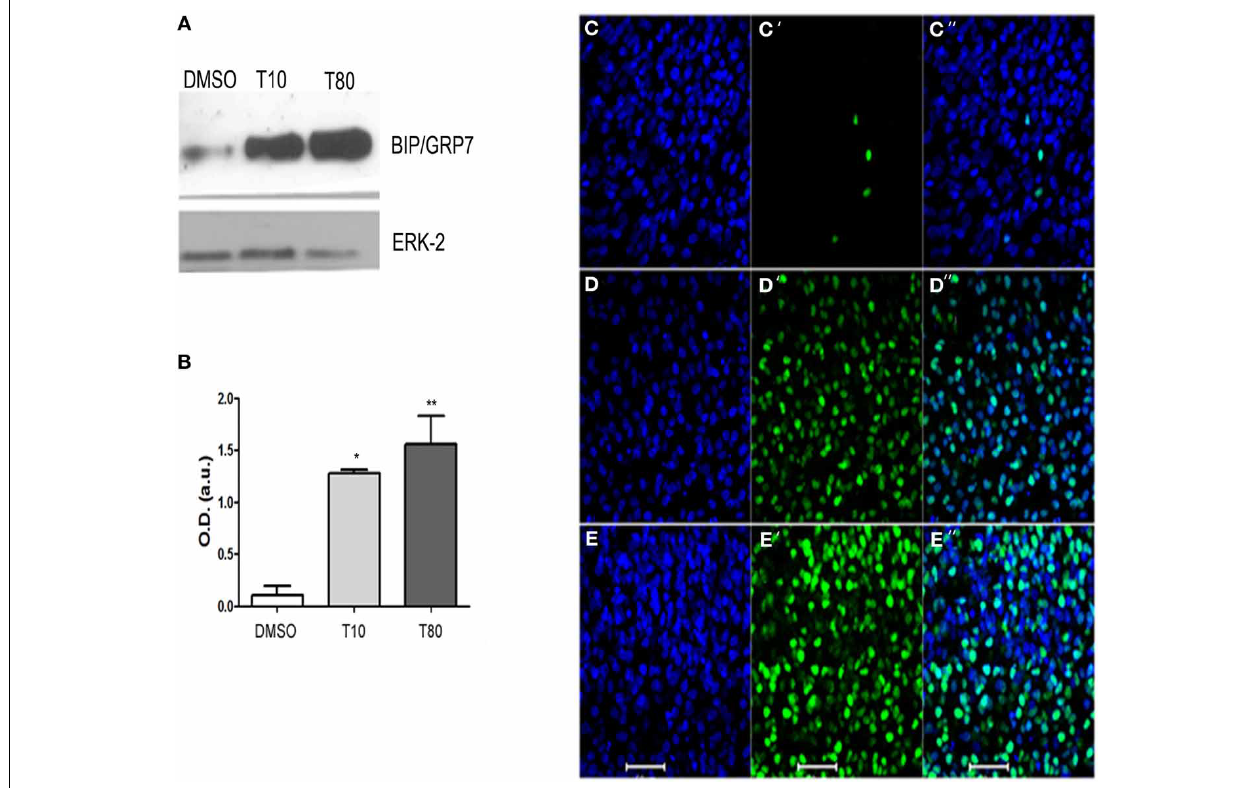
∗∗ p < 0 . 05. ANOVA was performed followed by Bonferroni’s post-test. P < 0 . 01, C.I.: 99.9%, N = 4 independent experiments. (C–E) Immunofluorescence for CHOP/GADD153 (green) and counterstaining of DNA with TO-PRO3 (blue) after Tunicamycin treatment at 10 (D) or 80 μ g/mL (E) or vehicles (C) . Note a nuclear localization of CHOP/GADD153. Scale bar: 20 μ